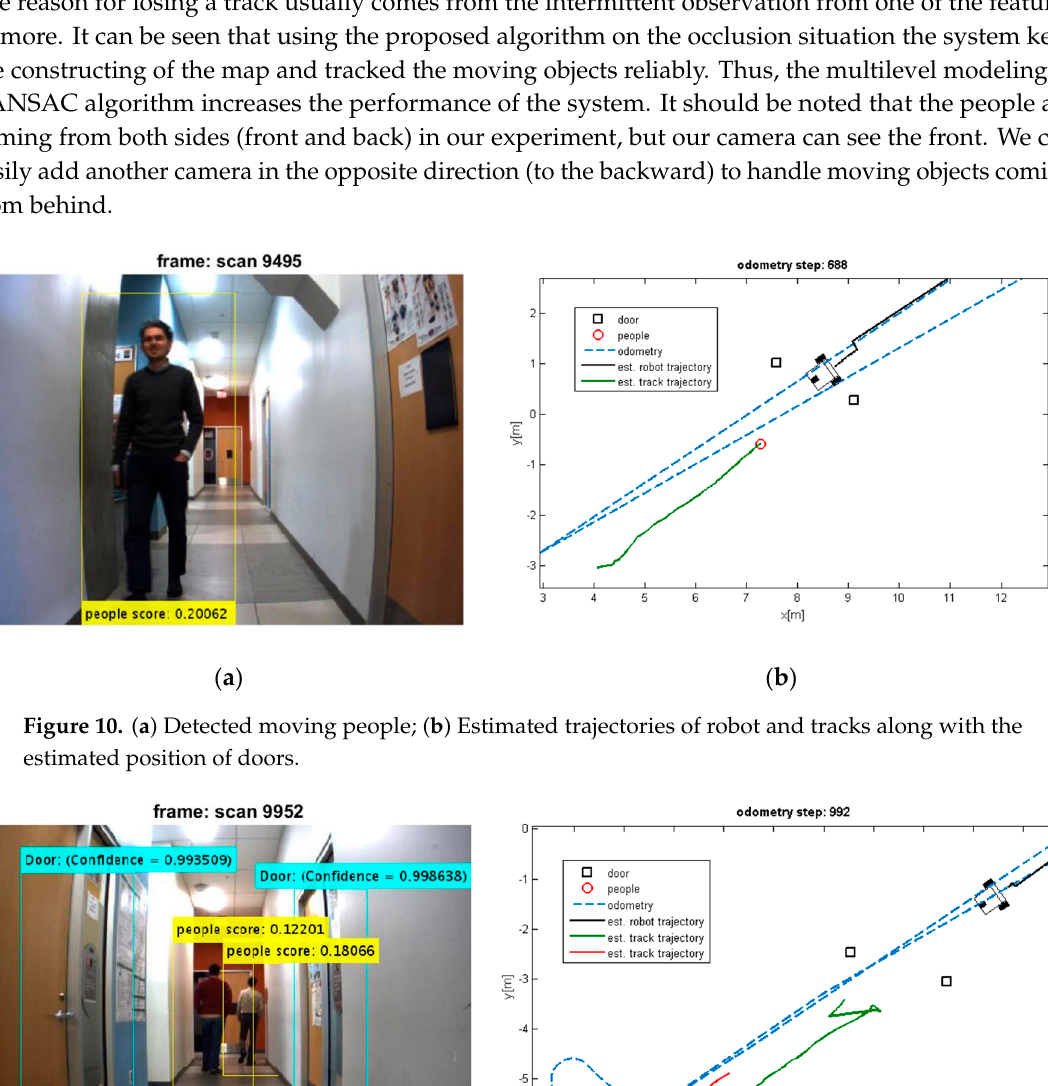
( b ) Figure 9. ( a ) Losing the detection of moving people; ( b ) Estimated trajectories of robot and tracks, whereas the proposed algorithm keeps tracking the moving object. It can be seen that the moving objects are tracked correctly through the motion. The trajectories of the mobile robot and tracks are also shown in these figures. Although the dynamic objects (people) are moving away from robot (Figures 8 and 9), sometimes they cannot be observed by sensors (Figure 9). In such cases, the estimator keeps tracking of the objects continuously while the mobile robot is